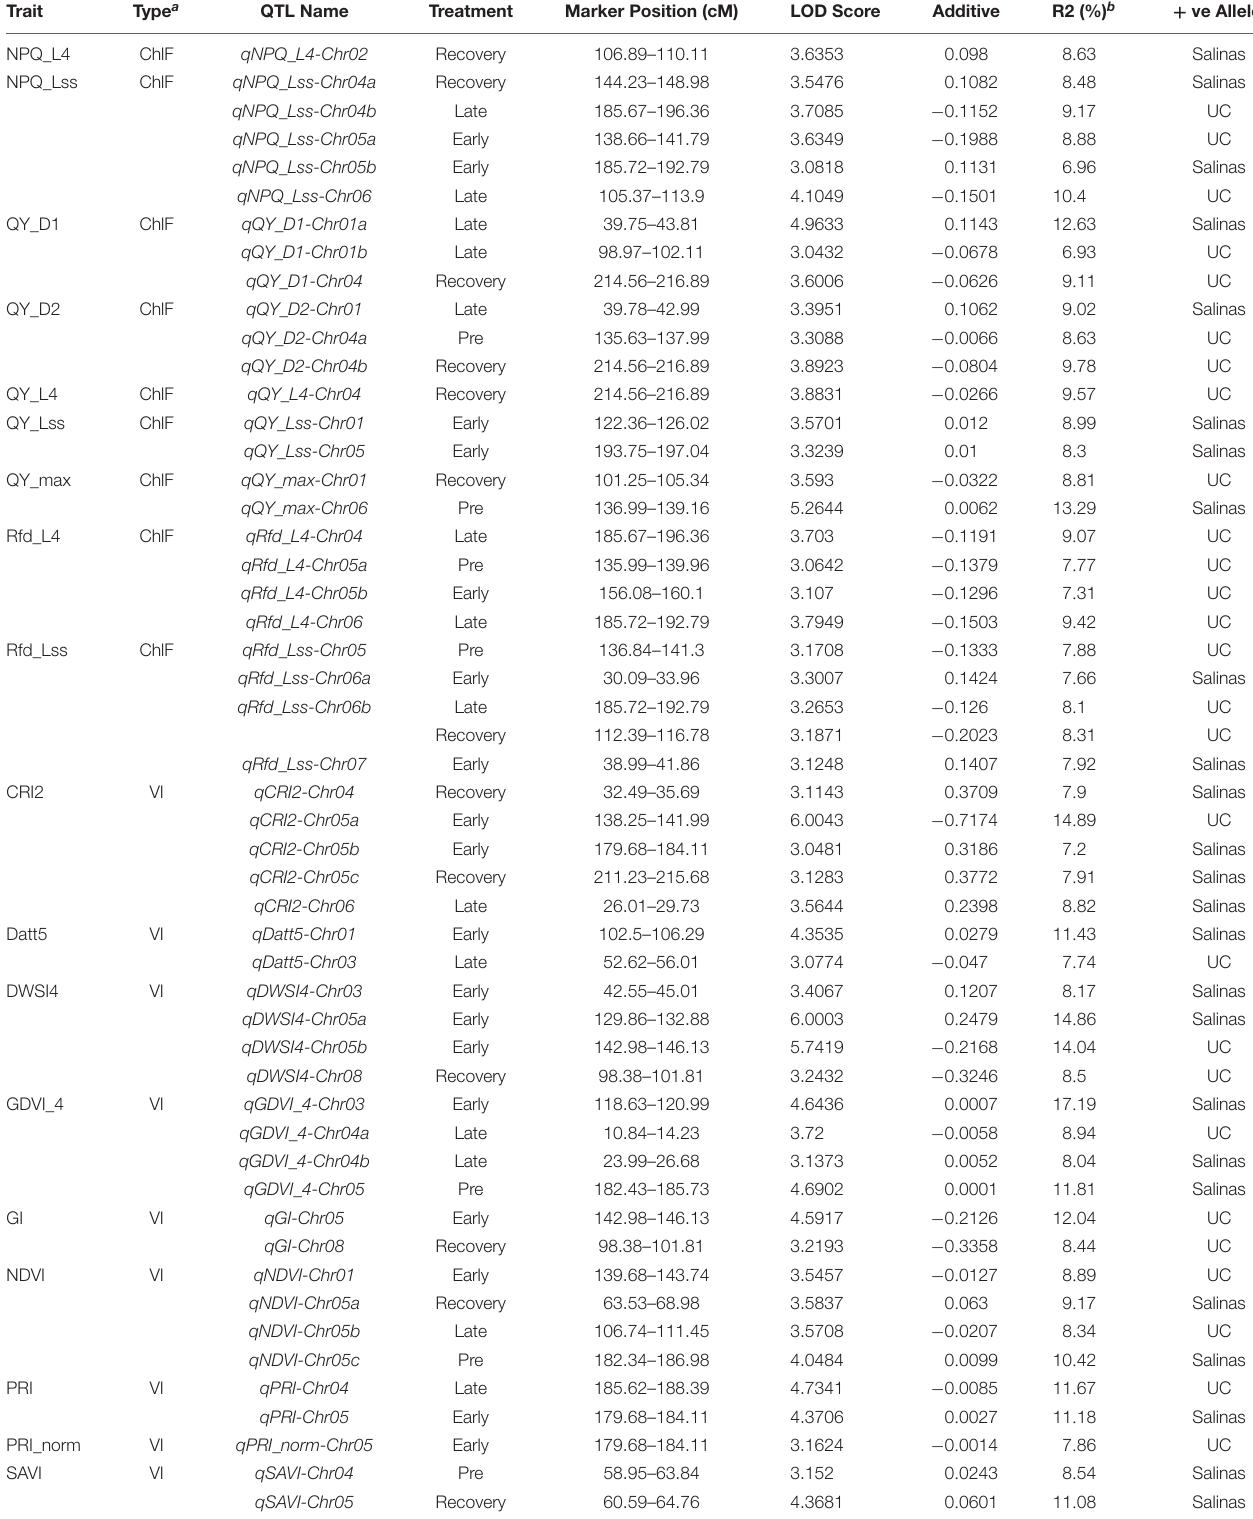
TABLE 5 | Summary of QTL affecting kinetic chlorophyll fluorescence parameters and vegetation indices during water-stress progression.